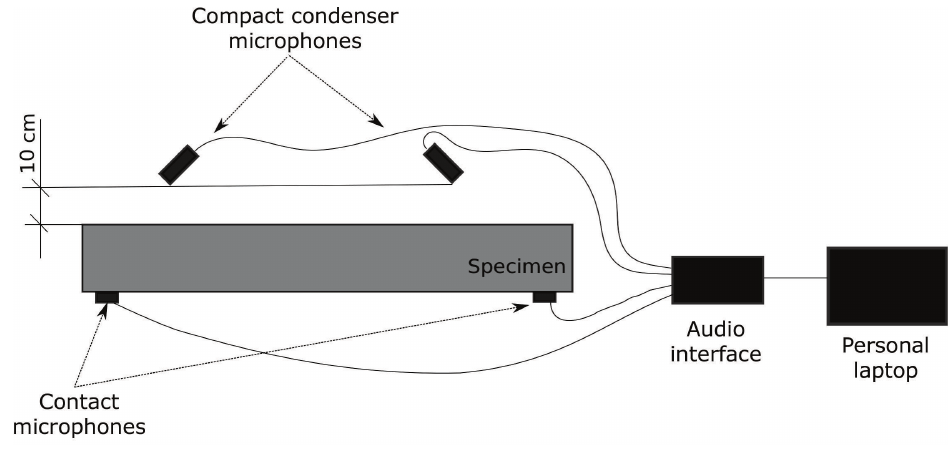
Fig. 6. An experimental setup for acoustic emission